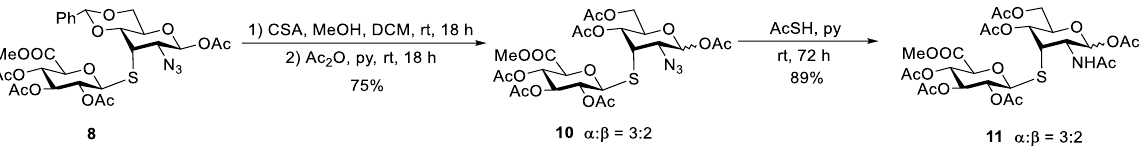
Table 1. 1 H and 13 C-NMR characteristic signals of thiodisaccharides 4 , 8 and 9 .